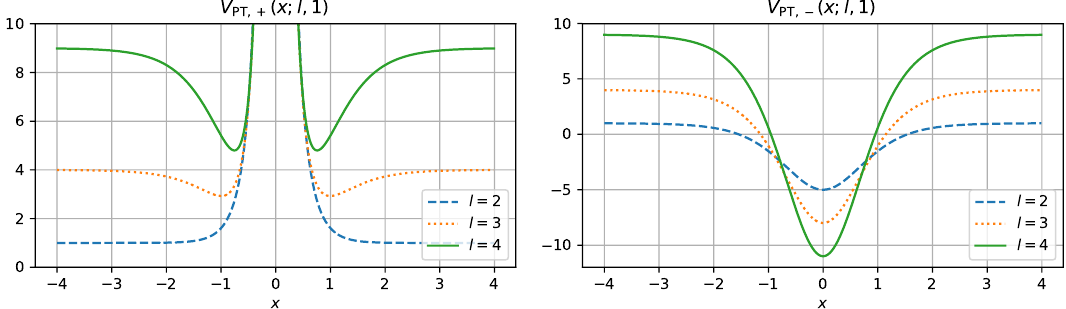
Figure 1 . Plots of the effective potential V eff ( x ) = V PT , + ( x ; l, 1) and its partner potential V PT , − ( x ; l, 1) for l = 2 , 3 , 4